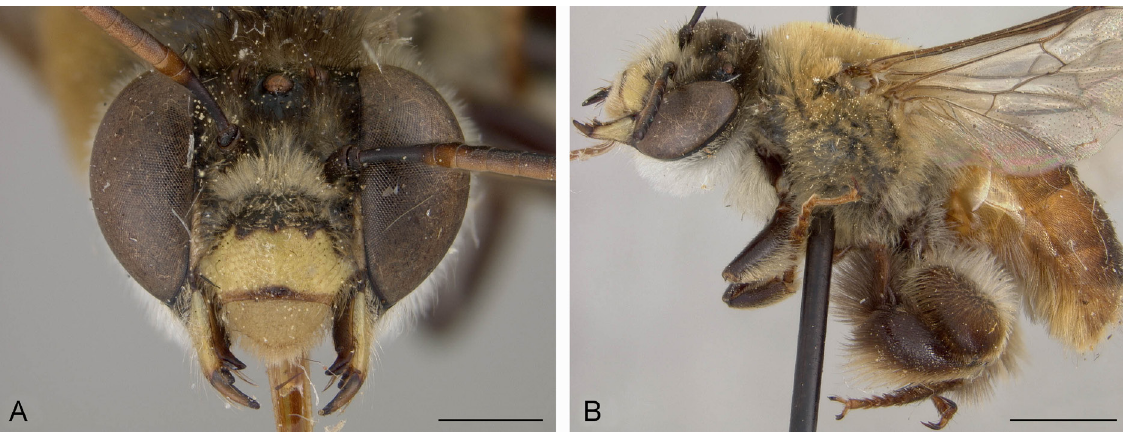
Fig. 10. Centris lanipes subtarsata Cockerell, 1949, holotype, ♂ (NMNH; USNM ENT 00534216). A . Frontal view. B . Habitus, lateral view. Scale bars: A = 1 mm; B = 2